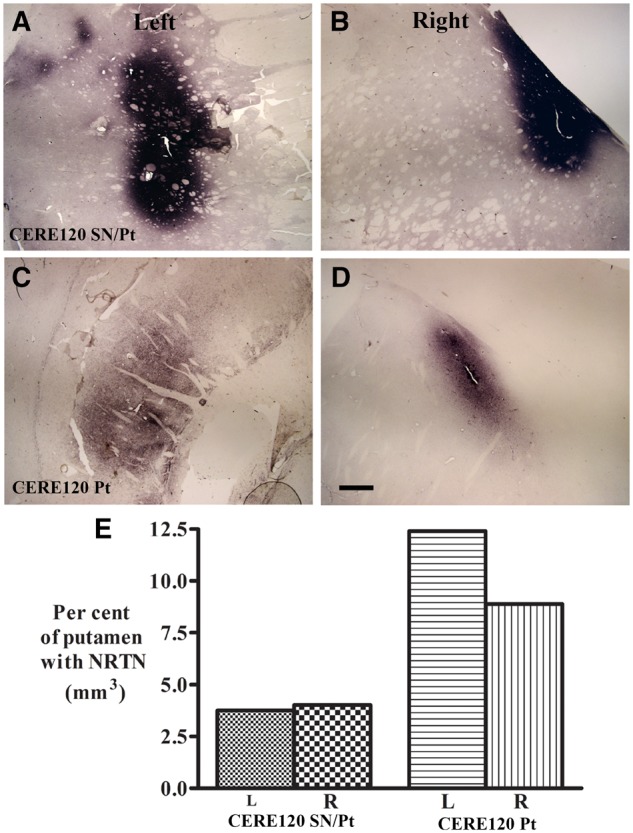

Qualitative and quantitative evaluation for NRTN expression in putamen. Photomicrographs of putamen from Parkinson’s disease subjects with combined nigral and putamenal CERE120 administration (CERE120 SN/Pt; A and B) or putamenal only (CERE120 Pt; C and D) illustrating neurturin (NRTN) immunohistochemical staining. Note NRTN was distributed within putamen in both cases. Case with combined putamenal and nigral CERE120 deliveries (A and B) displayed more intense in NRTN staining relative to putamenal deliveries only (C and D). Scale bar in D = 1 mm (applies to all). (E) Histogram depicts per cent of NRTN covering left (L) and right (R) putamen.